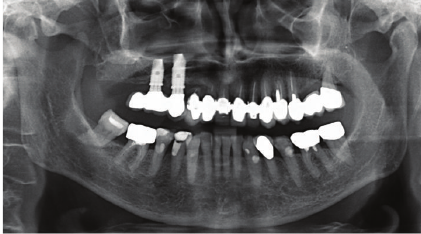
Figure 2: Panoramic X-ray: unilocular, well-defined radiolucency of the right maxillary sinus region without dental focus.